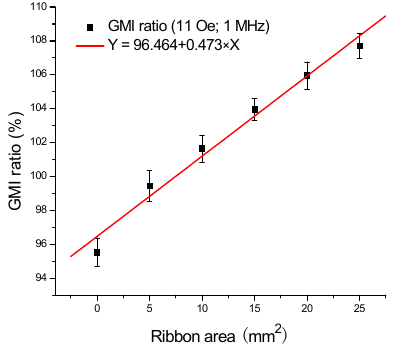
Figure 5. The typical linear relationship between the giant magnetoimpedance ratio and the ribbon area when the ribbons are tested on the top of the giant magnetoimpedance sensor I.